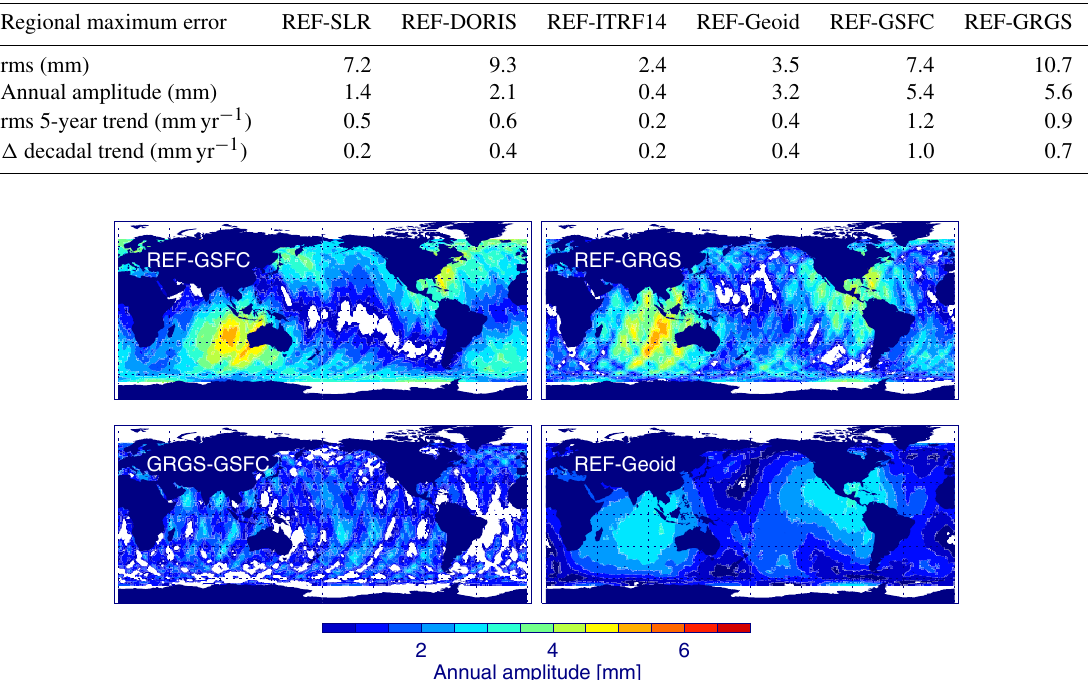
Figure 5. Annual amplitude of the radial orbit differences for REF minus GSFC, REF minus GRGS, GRGS minus GSFC, and REF minus Geoid. The regions with formal errors larger than the fitted value are masked out (white). The maximum amplitude difference is given in Table